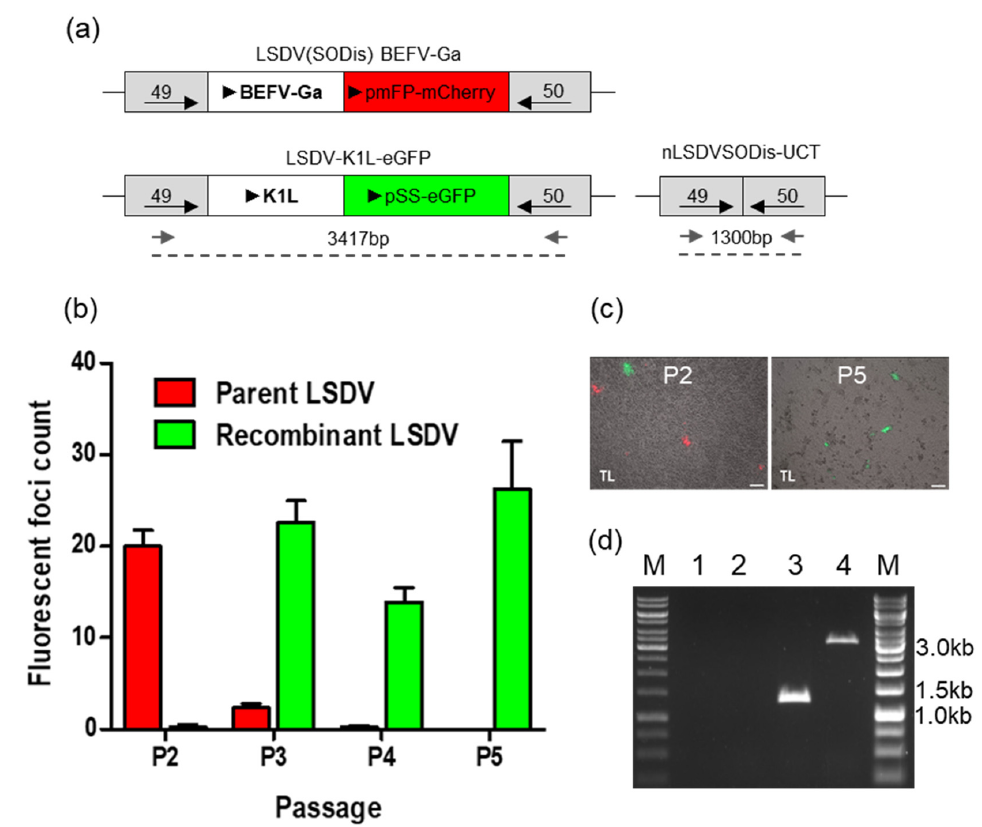
Figure 7. Generation of LSDV- K1L-eGFP in RK13 cells. ( a ) Schematic diagram of the parent virus, LSDV(SODis)BEFV-Ga, LSDV-K1L-eGFP and nLSDVSODis-UCT. ( b ) Fluorescing foci were counted as RK13 cell lysates were passaged (P2 to P5). Red and green bars indicate red and green foci counts respectively. ( c ) Images of passage 2 and 5 of potential LSDV-K1L-eGFP recombinant. Phase contrast with mCherry and eGFP, scale bar = 100µm. ( d ) PCR confirmation of LSDV-K1L-eGFP. DNA was extracted from infected BHK-21 cells and subjected to PCR using forward and reverse primers (small grey arrows) as indicated in A. M—GeneRuler 1 kb DNA Ladder, lane 1—water control, 2—uninfected cells, 3—nLSDVSODis-UCT, 4—LSDV-K1L-eGFP.